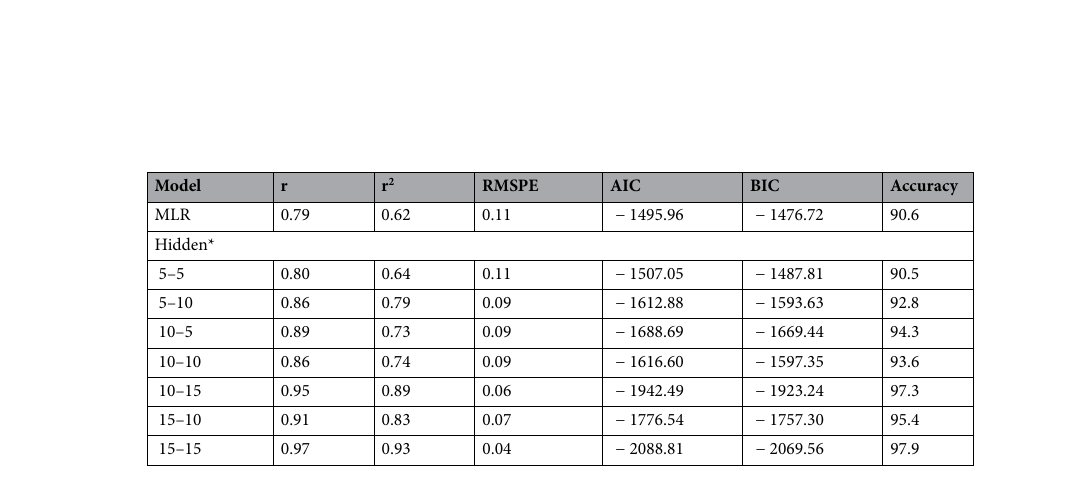
Table 1. Evaluation of goodness of fit of multiple linear models and artificial neural networks used to predict milk yield of Pelibuey sheep. MRL multiple linear regression model, r correlation between actual and predicted BIC Bayesian’s Information Criterion. *Number of neurons layer 1- number of neurons layers